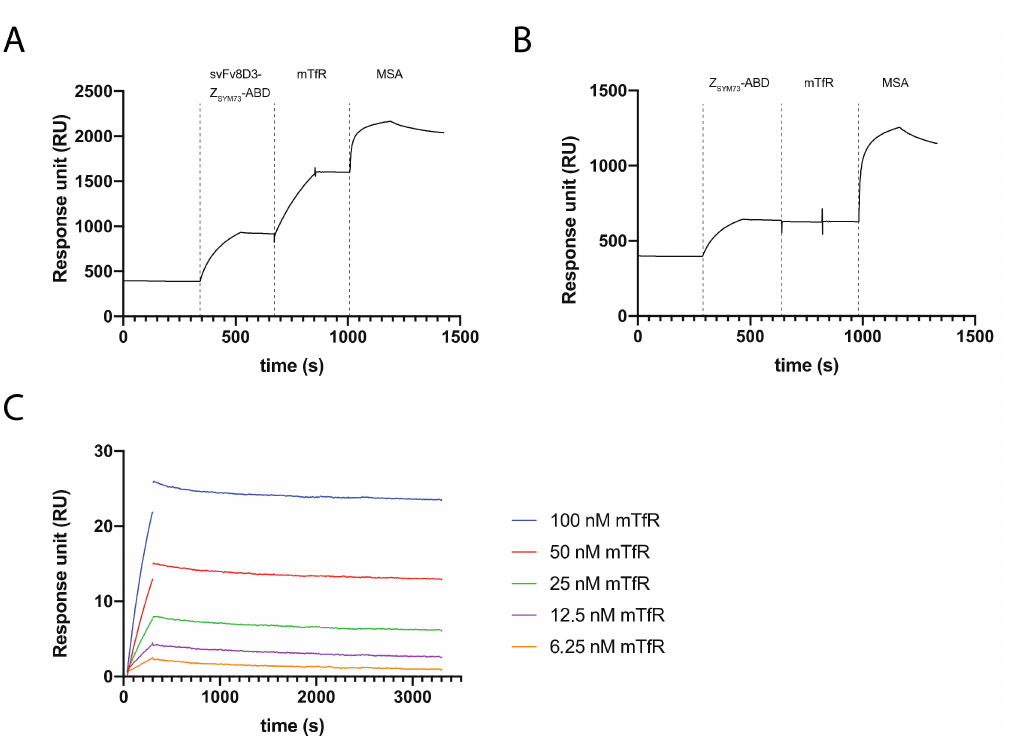
Figure 2. Surface plasmon resonance (SPR)-based biosensor assays. ( A ) Representative sensorgram showing the results from a triple co-inject assay. A β 1-40 is immobilized on the surface, and scFv8D3-Z SYM73 -ABD, mTfR, and mouse serum albumin (MSA) are injected subsequently. ( B ) Representative sensorgram showing the results from a triple co-inject assay. A β 1-40 is immobilized on the surface, and Z SYM73 -ABD, mTfR, and MSA are injected subsequently. Respective start points of injections are marked with a dashed line and the injected protein is stated over respective part of the sensorgram. ( C ) Representative sensorgram from the kinetic analysis of the interaction between mTfR and scFv8D3-Z SYM73 -ABD. All experiments were performed in duplicates. The gaps in the sensorgrams at the end of injection are from removal of spikes in signal by the Biacore evaluation